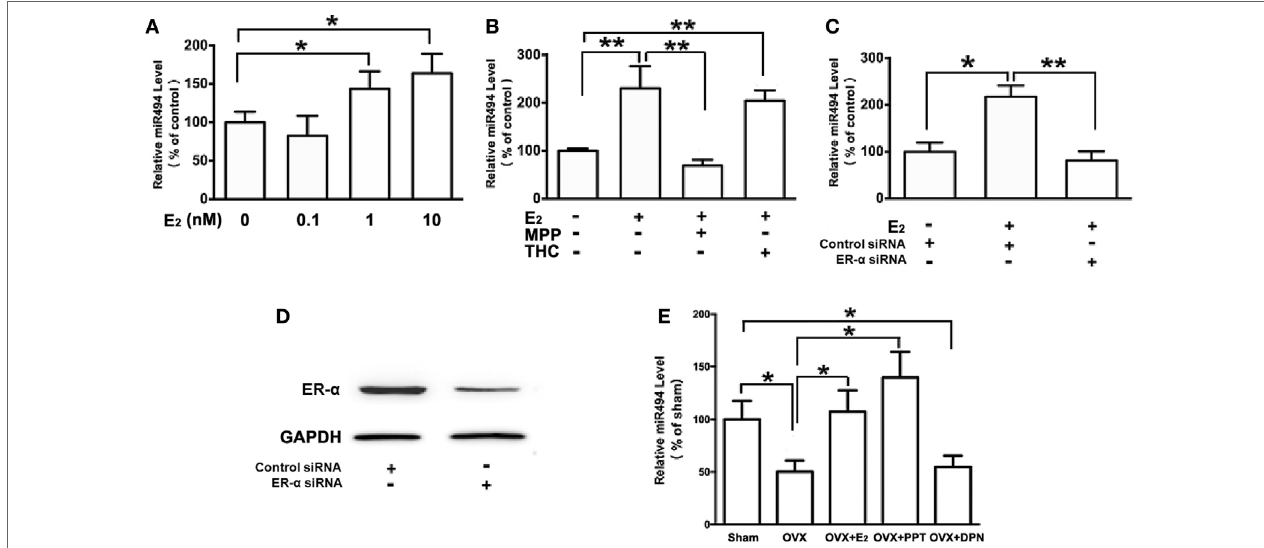
FigUre 2 | ER α mediates the regulation of miR-494 expression by E 2 in cardiomyocytes and myocardium. (a) H9c2 cells were stimulated with E 2 at indicated doses for 24 h. Quantitative real-time RT-PCR was used to determine miR-494 expression in cardiomyocytes by performing four independent experiments. (B) Cells were treated with E 2 (10 nmol/L) in the absence or presence of ER α -specific antagonist MPP (1 µmol/L), or ER β -specific antagonist THC (1 µmol/L) for 24 h. Quantitative real-time RT-PCR was used to determine miR-494 expression in cardiomyocytes by performing four independent experiments. (c) Cells were transfected with Control siRNA or ER α siRNA for 24 h and then treated with E 2 (10 nmol/L) for another 24 h. Quantitative real-time RT-PCR was used to determine miR-494 expression in cardiomyocytes by performing four independent experiments. (D) Cells were transfected with Control siRNA or ER α siRNA for 24 h. Western blot analysis were used to determine ER α protein expression in cardiomyocytes by performing four independent experiments. (e) Bilateral ovariectomy was performed on female mice to deplete endogenous estrogens. Exogenous E 2 , ER α selective agonists (PPT) and ER β selective agonists (DPN) were subcutaneously administered for four weeks. Quantitative real-time RT-PCR was used to determine miR-494 expression in the myocardium ( n = 8 in each group). All bar graphs represent the mean ± SEM. * P < 0.05, ** P <